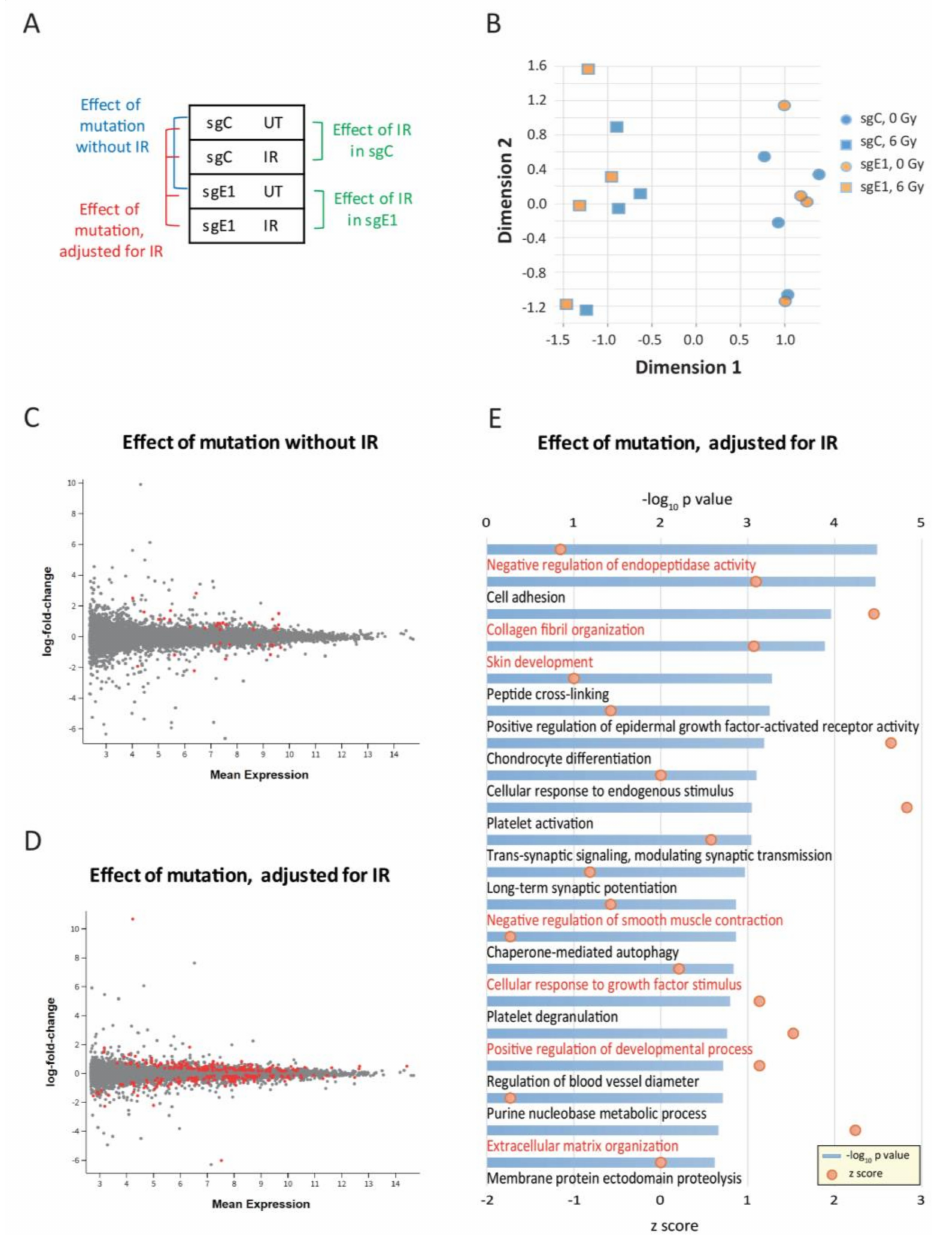
Figure 3. Genome-wide effects induced by loss of EGR1-binding at the DGKA enhancer. ( A ) Schematic diagram of the comparisons between control cells (sgC) and sgE1 cells with loss of EGR1-binding at the DGKA enhancer. ( B ) Multi- dimensional scaling (MDS) plot comparing all genes expressed in sgC and sgE1 cells with or without irradiation treatment (6 Gy). ( C ) Plot presenting the differentially expressed genes (DEGs) obtained from the comparison of sgC and sgE1 cells without irradiation. ( D ) Plot presenting the DEGs of sgC and sgE1 cells with and without irradiation, adjusted for irradiation. Mean expression values are log-normalized. Genes with adjusted p -values (p-adj) < 0.05 are highlighted in red. ( E ) Gene ontology (GO) analysis of DEGs from the comparison presented in Figure 3D. To identify the effect of the binding site mutation, statistical tests were adjusted for irradiation. Significance (-log 10 ( p value)) of GO terms is presented by blue bars, and z scores are shown with red dots. Biological functions and pathways potentially related to fibroblast activation and fibrosis development are highlighted in